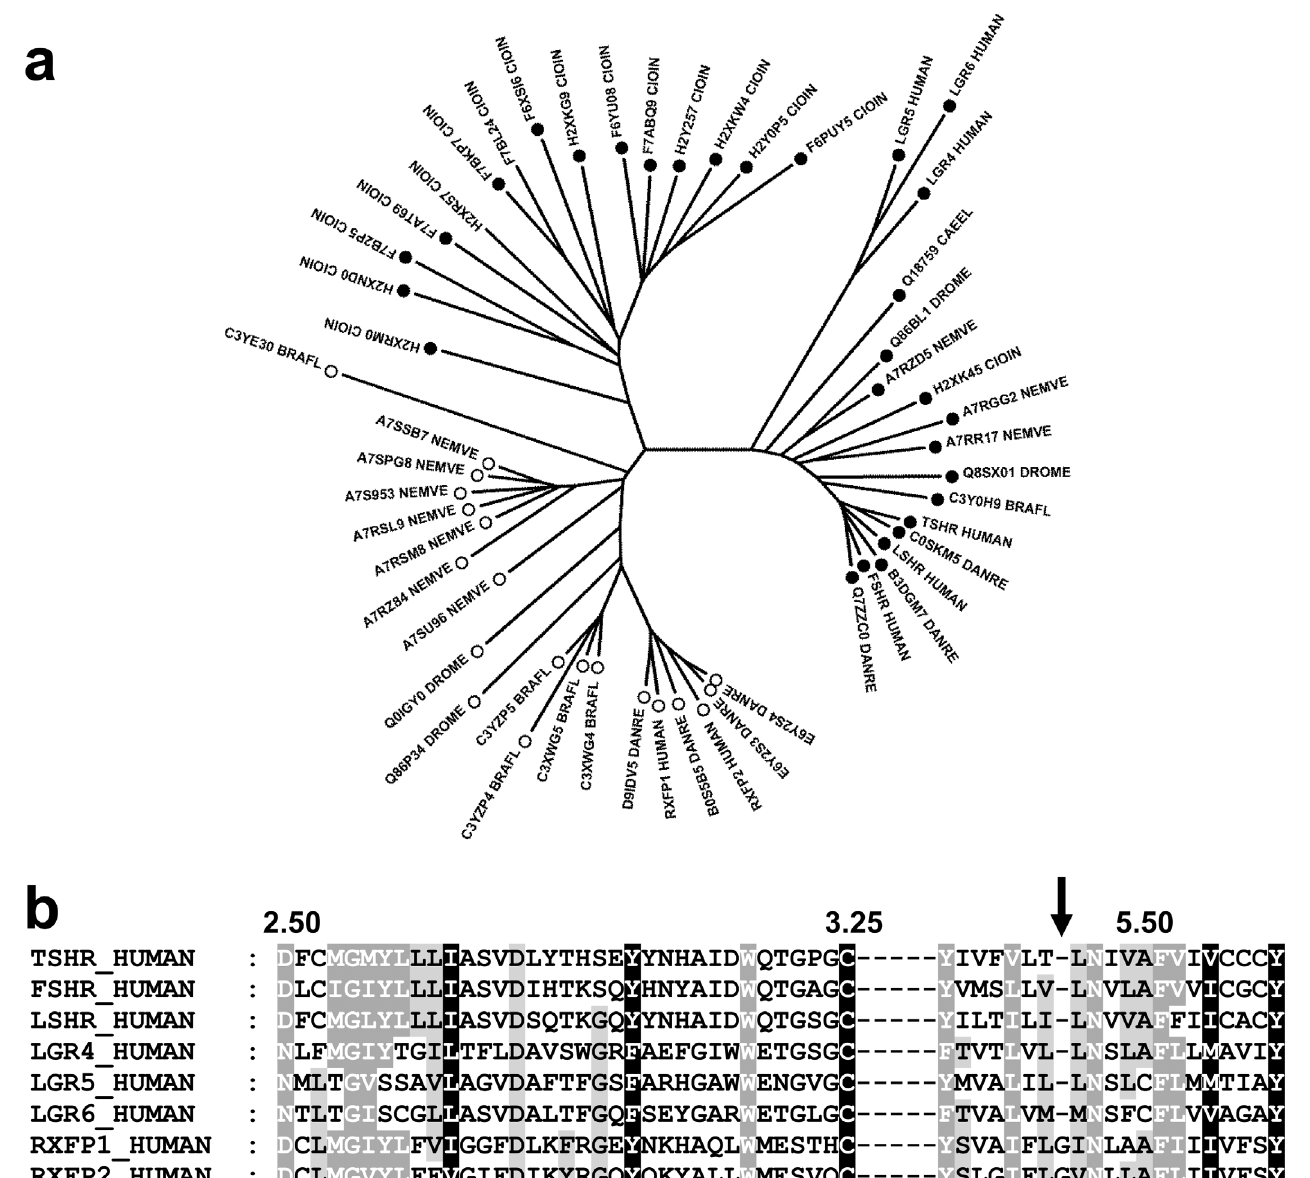
Fig 2. Evolution of LGR receptors. (a) NJ tree of 52 LGR receptors from seven species. The Y5.38 and Y5.39 patterns are indicated by an open and a closed symbol, respectively. (b) Sequence alignment of residues 2.50 to 3.25 and residues 5.38 to 5.58 of the human LGR receptors. The shading corresponds to the alignment of the 52 sequences. Fully conserved positions are shaded in black, partially conserved or type-conserved positions are shaded in dark grey (80% conservation) or light grey (60% conservation).